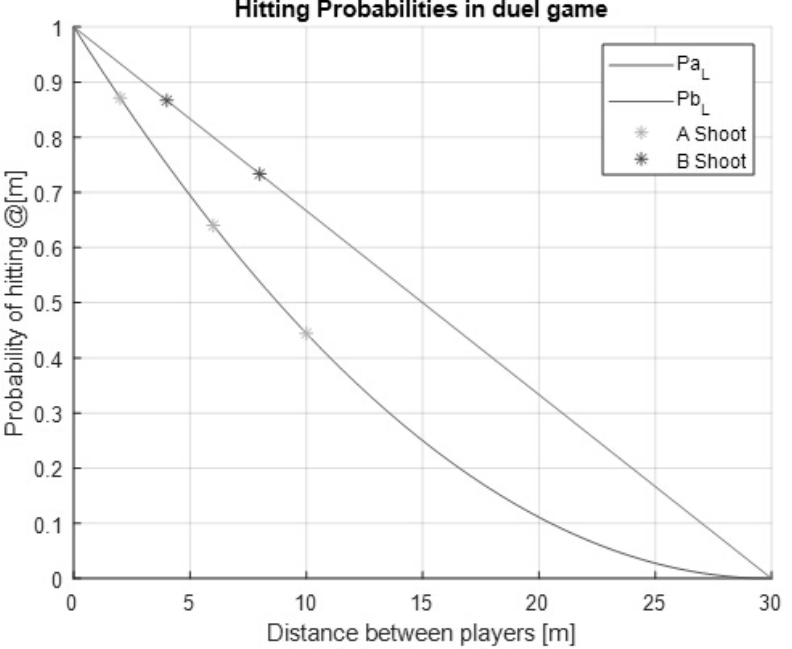
Figure 2. Probability of hitting for both